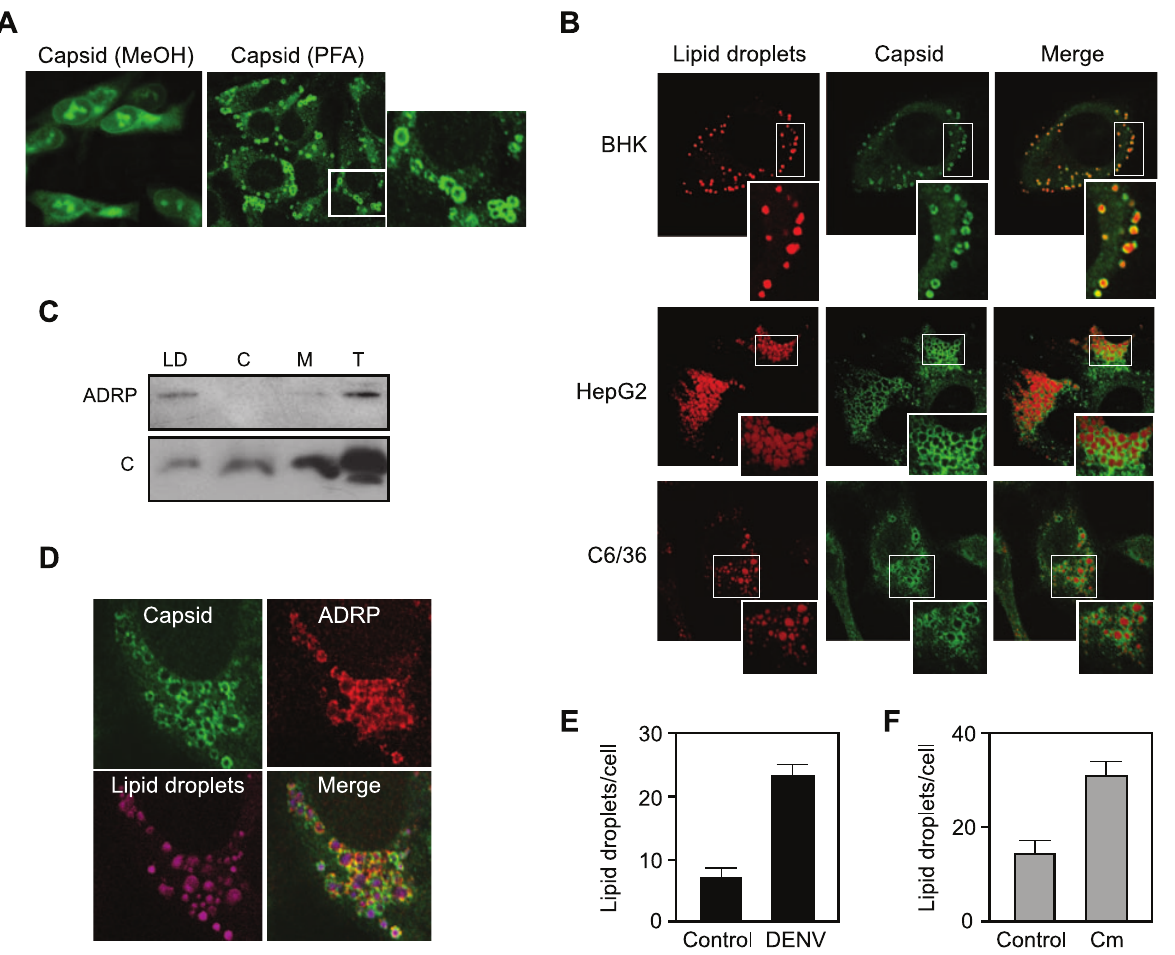
Figure 1. DENV infected cells accumulate the C protein around lipid droplets. A. Nuclear and cytoplasmic distribution of C protein in DENV infected BHK cells. Cells were infected with DENV2 and analyzed by immunofluorescence using a polyclonal anti-C antibody. Cells were fixed with methanol (MeOH) or paraformaldehyde (PFA) as indicated on the top. B. The C protein is targeted to lipid droplets. BHK, HepG2, and C6/36 cells were infected with DENV2, fixed at 48 h post-infection, probed with anti-C antibodies and BODIPY for lipid droplets staining, and examined by confocal microscopy. C. Subcellular fractionation of LDs. DENV-infected cell lysates were fractionated into lipid droplets (LD), cytosol (C), and microsome (M) fractions by sucrose gradient centrifugation. A total cytoplasmic extract was also included (T). The samples were immunoblotted with anti-ADRP and anti-C antibodies. D. Co-localization of C and ADRP on LDs. DENV infected BHK cells were analyzed by immunofluorescence with anti-ADRP and anti- C antibodies, and stained with BODIPY. E. DENV infection increases the number of lipid droplets. The amount of lipid droplets in control or DENV infected BHK cells were determined. Cells were fixed 48 h post- infection, incubated in 1.5% of OsO 4 , and lipid bodies were enumerated by light microscopy in 50 consecutive cells in each slide in triplicates. The bars indicate the standard error of the mean ( + / 2 SEM), (P , 0.0002). F. Expression of C protein increases the number of lipid droplets. The amount of lipid droplets in control or C expressing BHK cells were determined as described above. The bars represent the standard error of the mean (P ,